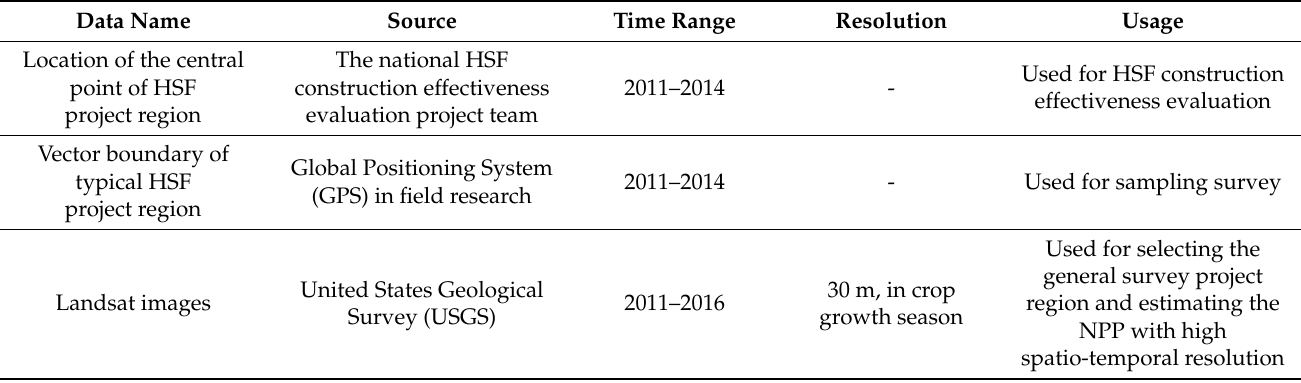
Table 1. Types and sources of data in this